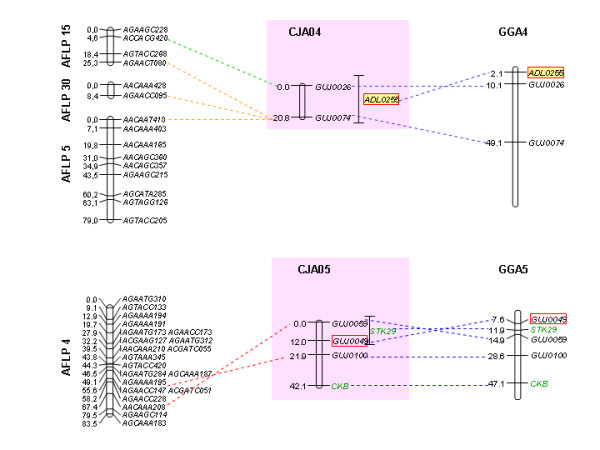
Alignments of Japanese quail microsatellite and AFLP maps and links to the assembled chicken sequence. Left: AFLP linkage groups from [14]; center: integrated microsatellite and gene map (this study); right: chicken February 2004 sequence assembly [22]. AFLP and microsatellite genetic maps are in cM and the sequence assembly is in Mb. New quail linkage groups have blue titles and new microsatellite and gene markers are in green. Genes are in boldface italic. Microsatellite markers informative in both species are in red boxes. Chicken markers have a yellow background. Quail microsatellites or genes with similarity to chicken sequence of unknown location (chrun) have a blue background. Dotted lines linking the microsatellite and the AFLP maps indicate positive results of two-point linkage between the markers, with supporting LOD scores of 3 to 6 (green), 6 to 10 (orange) or more than 10 (red).